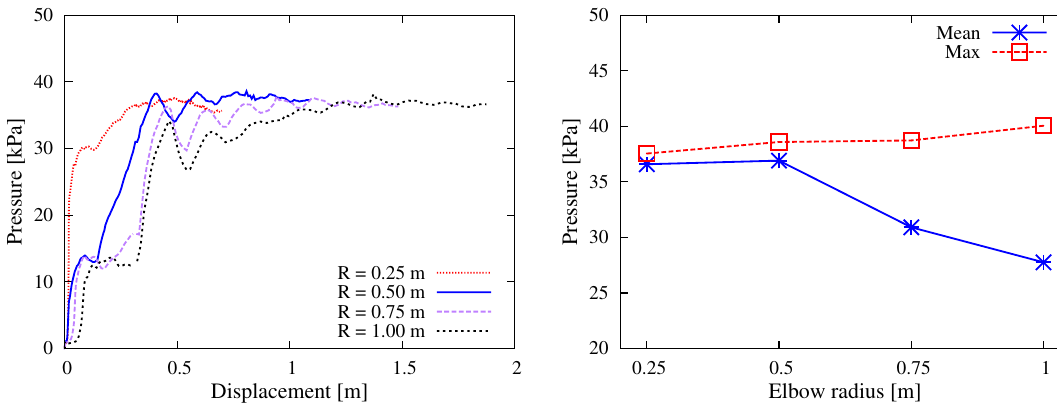
Figure 12. Simulation results with respect to the elbow curvature: ( left ) curves of the thrusting pressure vs. displacement relationship; and ( right ) mean and max values during the stable pumping stage.